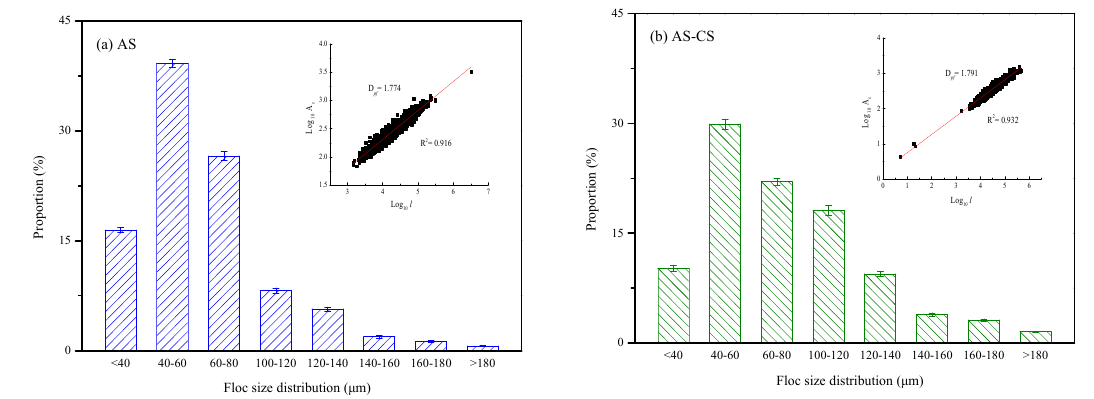
Figure 8. Floc size distribution and fractal dimension after ( a ) AS and ( b ) AS-CS coagulation